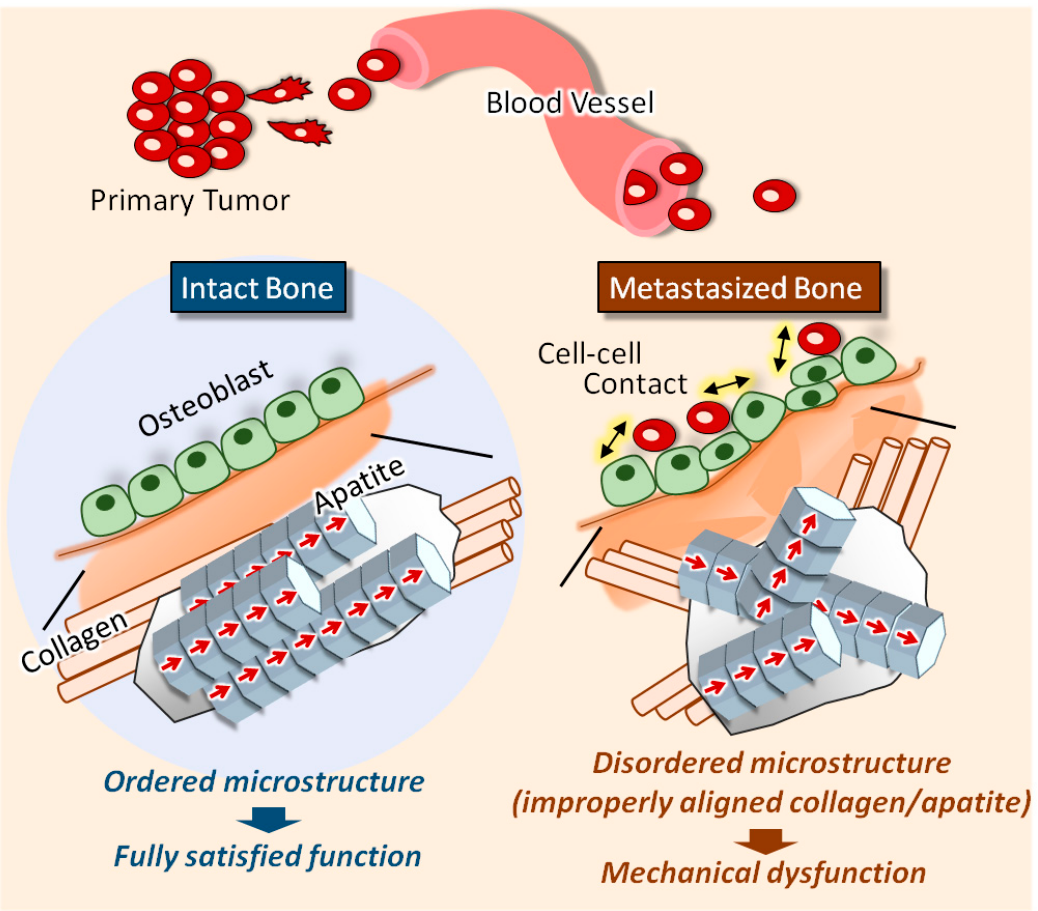
Figure 5. Schematic illustration of the deterioration of the collagen/apatite orientation in metastasized bone. The intact bone tissue shows the preferred orientation of collagen fibers and the c -axis orientation of apatite crystals along the longitudinal direction of long bones. Metastasized bone shows a disrupted collagen/apatite orientation, which is correlated to the disarrangement of osteoblasts on the bone surface.